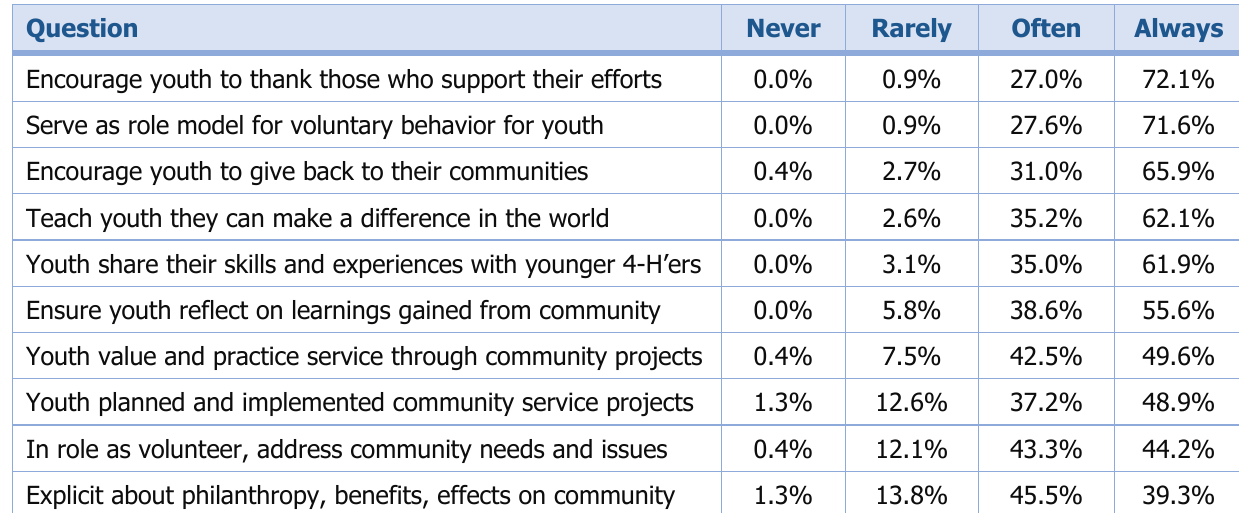
Table 5. Frequency of Volunteer Responses to Questions on Practices That Promote